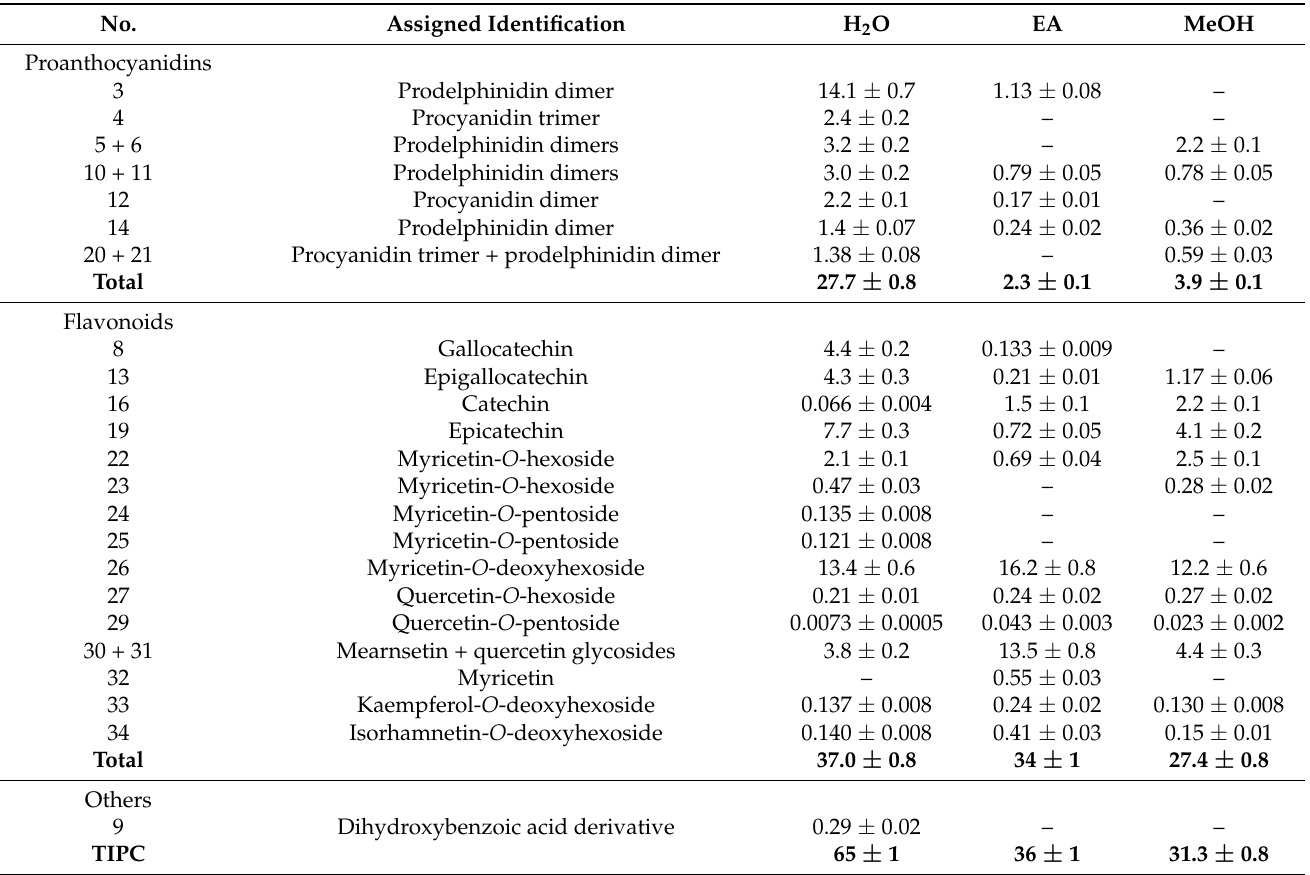
Table 3. Quantification of the main phytochemicals in the analyzed extract of T. peltata (mg g − 1 dry extract (DE); n =